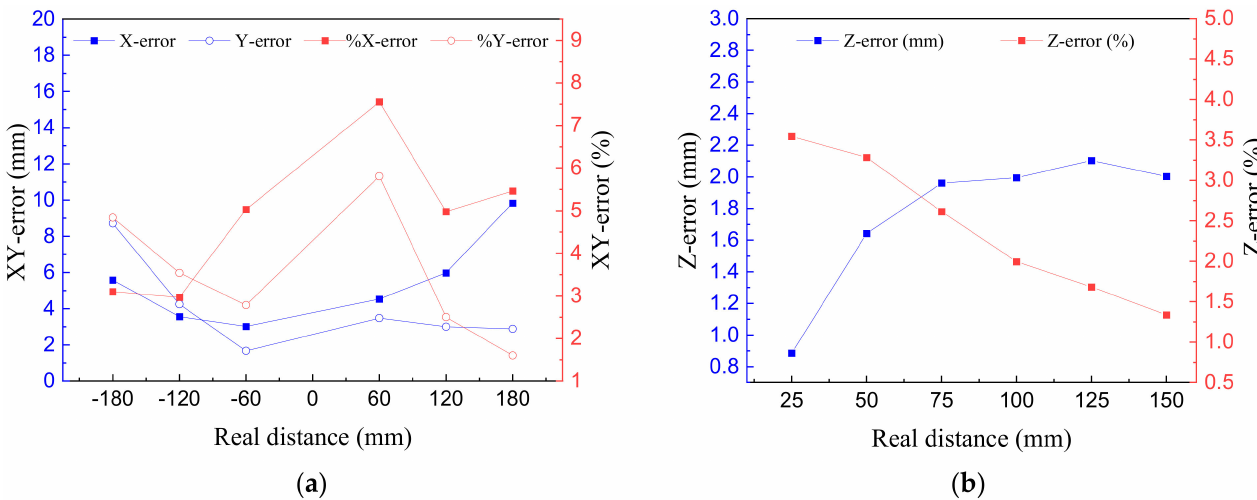
Figure 11. Translation errors of workpiece modeling at different estimated poses for the ( a ) XY -axis and the ( b ) Z -axis.